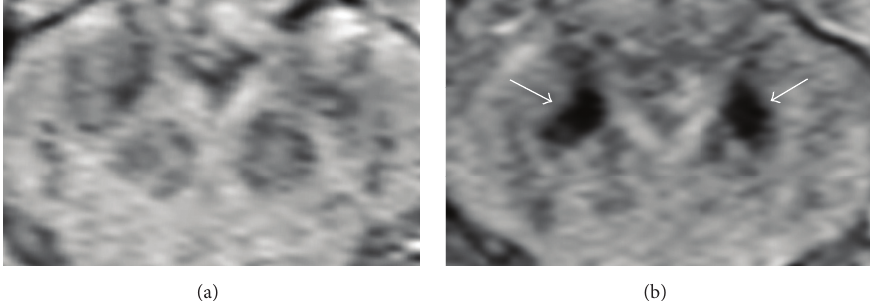
Figure 6: Axial images through the level of the substantia nigra demonstrating iron deposition patterns in a control subject (a) and PD subject (b), with the PD subject showing focally high susceptibility at the caudal aspect of the FN tract (white arrows) (SWI, 2 mm).